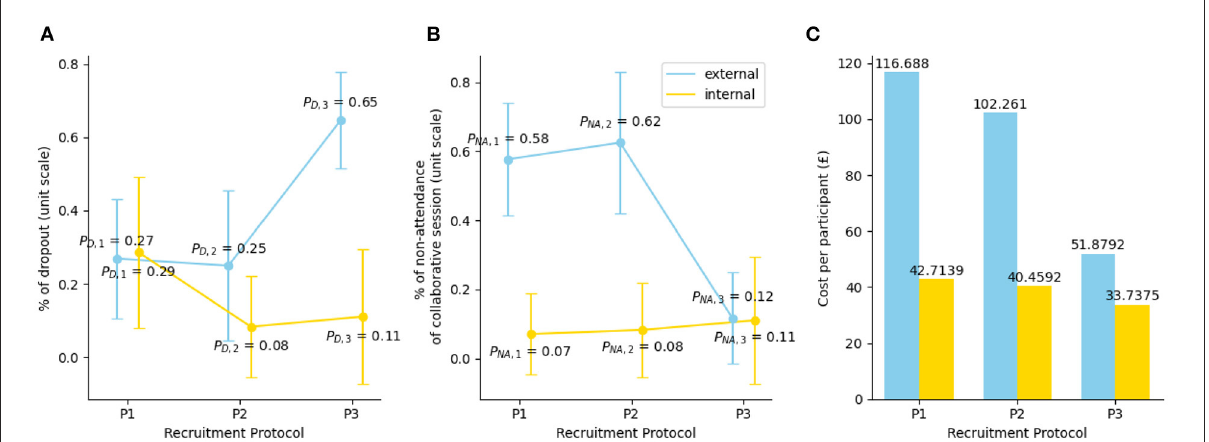
FIGURE2 (A) Dropout across the different protocols and internal-external groups errors bar represent the 95% confidence intervals (which contains 95% of the sample), P D , i represents the probability of dropout for protocol i . (B) On the left non-attendance across the different protocols and internal-external groups, errors bar represent the 95% confidence intervals, P NA , i represents the probability of non-attendance for protocol i . (C) Shows the cost per participant across the different groups (internal/external) and the different recruitment protocols calculated with the function 2.2.